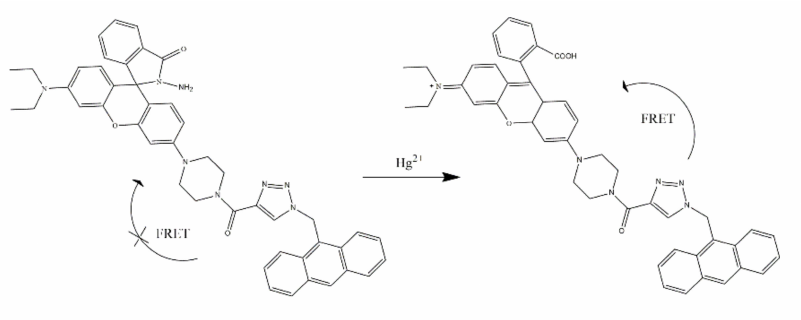
Figure 12. The proposed sensing mechanism of the prepared sensor (Table 1, No. 16) for Hg 2+ [48].